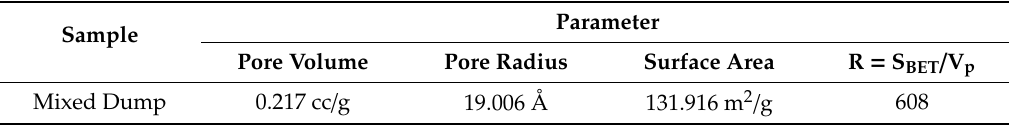
Table 5. Morphological characteristics of the mixed dump as established through BET